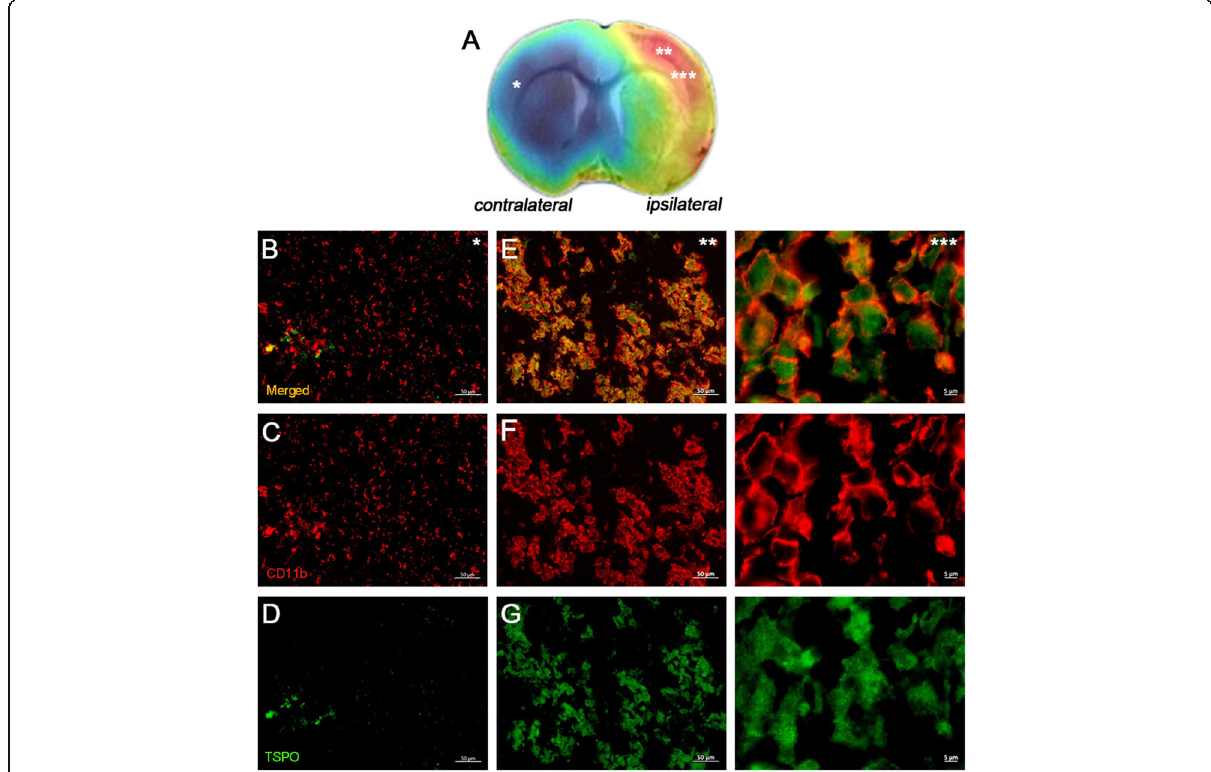
Fig. 7 Immunofluorescent labeling of CD11b (red) and TSPO (green) in the contralateral and the ischemic area shown as two channels. The data show the TSPO expression in microglial cells at day 7 after cerebral ischemia. a Regions selected for immunohistochemistry studies (*, **, and ***) in a PET image of [ 18 F] VUIIS1008 co-registered with the MRI-T 2 W of the same animal at day 7 after MCAO. b , e Merged images for the two immunofluorescent antibodies in the contralateral and ipsilateral brain hemispheres at different magnifications (*20× and **100×). f CD11b-reactive microglia/macrophages are increased in the lesion. g TSPO overexpression corresponds to the CD11b-reactive cells. Scale bars *50 μ m and **5 μ